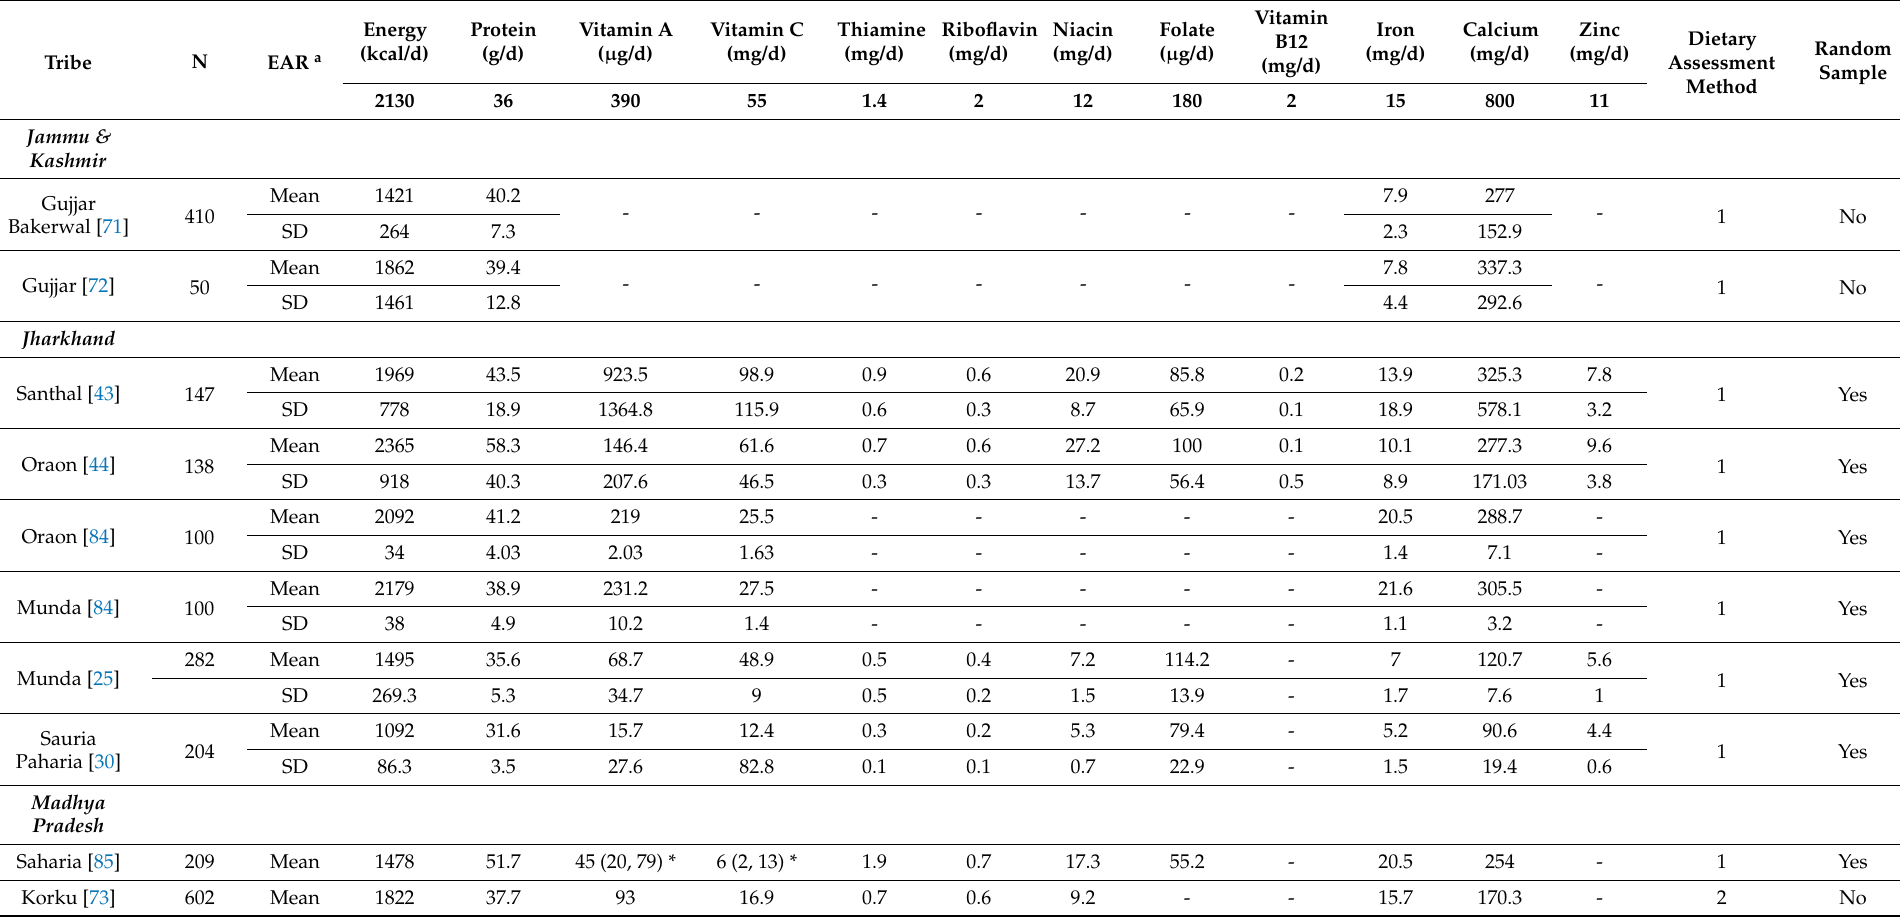
Table 1. Mean nutrient intakes among indigenous women of